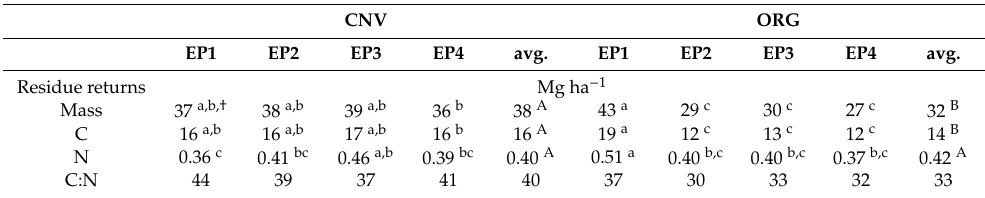
Table 5. Cumulative mass, C, and N of residue returns from 2002–2009, by conventional (CNV) and organic (ORG) system and entry point